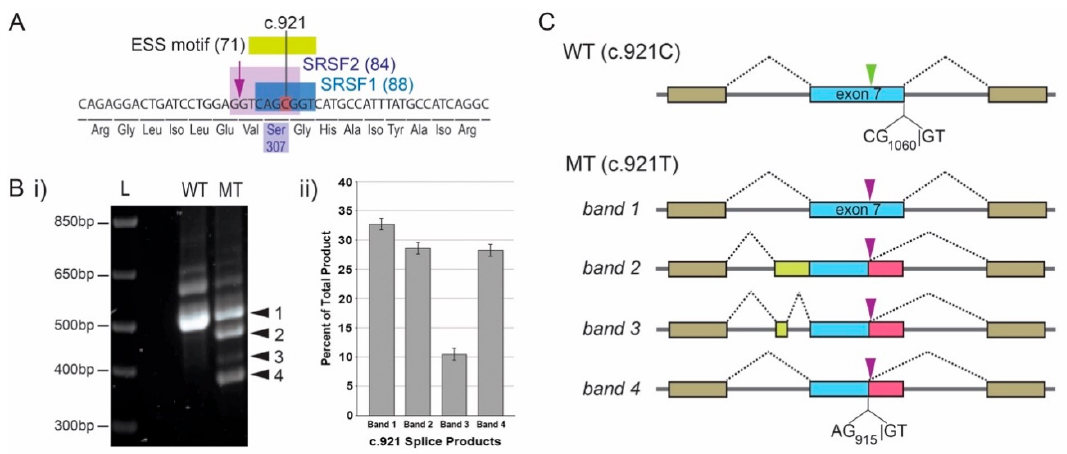
Figure 2. The synonymous IRF6 c.921C > T variant impacts splicing. ( A ) In silico analysis predicted the creation of an exonic splice silencer (ESS) element (score: 71) and enhanced putative recognition sites for the splicing factors, including SRSF1 and SRSF2. The scores are indicated in brackets. ( Bi ) In vitro minigene splice assay detected multiple abnormal splice products (bands 2–4) in addition to the normal-sized product (band 1). Note: the slower migrating bands were seen with both the wildtype and mutant and are thought to represent pre-spliced forms, as they were absent from control PCRs using the RNA (without reverse transcriptase) as a template. ( Bii ) Quantification of splice products revealed that abnormal products constituted ~67% of allelic transcripts. ( C ) Sequencing of purified splice products resolved the nature of the underlying splice events. The arrowheads depict the location of nucleotide position c.921: C = green; T = purple. The variant unmasks the cryptic exonic splice site at position c.915, as well as a site within intron 6 (135 nucleotide 5 ′ of the canonical 5 ′ splice acceptor of exon 7). The canonical acceptor site is used differentially in bands 2 and 3.